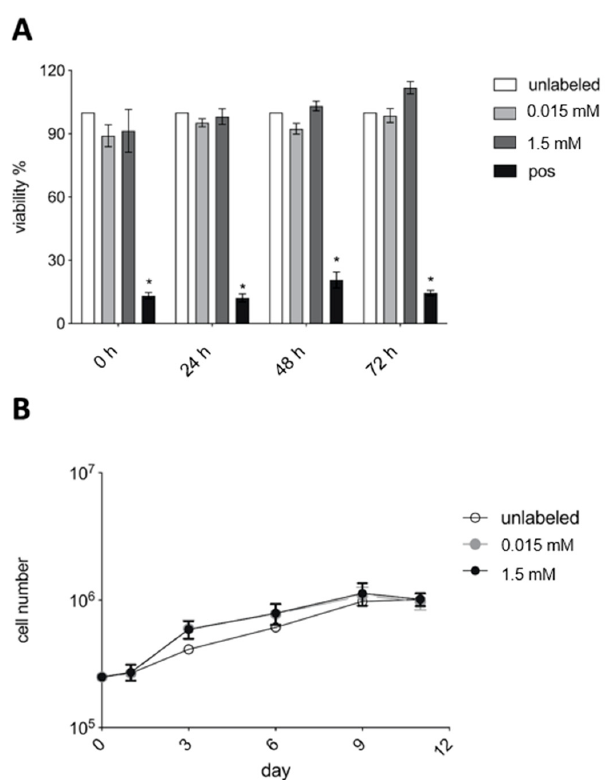
Figure 6. MTT and proliferation assay: ( A ) There was no difference between the viability of hASCs, which were labeled with 0.015 mM (light grey columns) and 1.5 mM VSOPs (dark grey columns), and unlabeled cells (white columns) immediately after the labeling procedure and after 24, 48 and 72 h. The values of the unlabeled cells were normalized to a viability of 100% for each single patient. Mean extinction values for each patient and concentration were normalized to the respective values of unlabeled hASCs from the same patient. Human ASCs treated with tert-butylhydroperoxide (t-BHP) (black columns) showed a significant decrease in cell viability compared to VSOPs-labeled and unlabeled hASCs. Significance is indicated by asterisks (* p < 0.0001). ( B ) VSOPs-labeled hASCs showed no difference in proliferation capacity compared to the unlabeled controls.